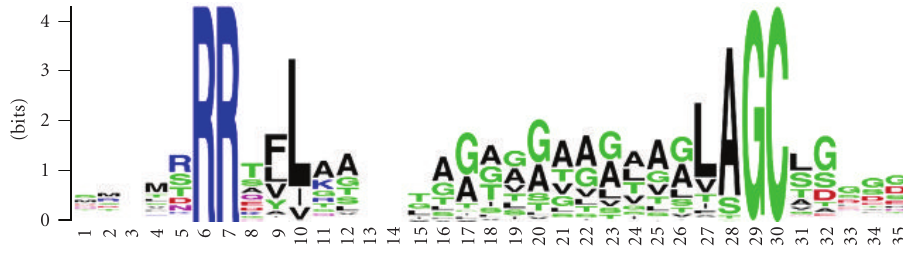
Figure 6: Conserved lipobox motifs of haloarchaea. Consensus motif was generated using the lipobox motifs of 400 predicted haloarchaeal Tat lipoproteins (see Supplementary Table 4). The alignment depicts the cleavage site G/A at position − 1. Logos were generated using weblogo